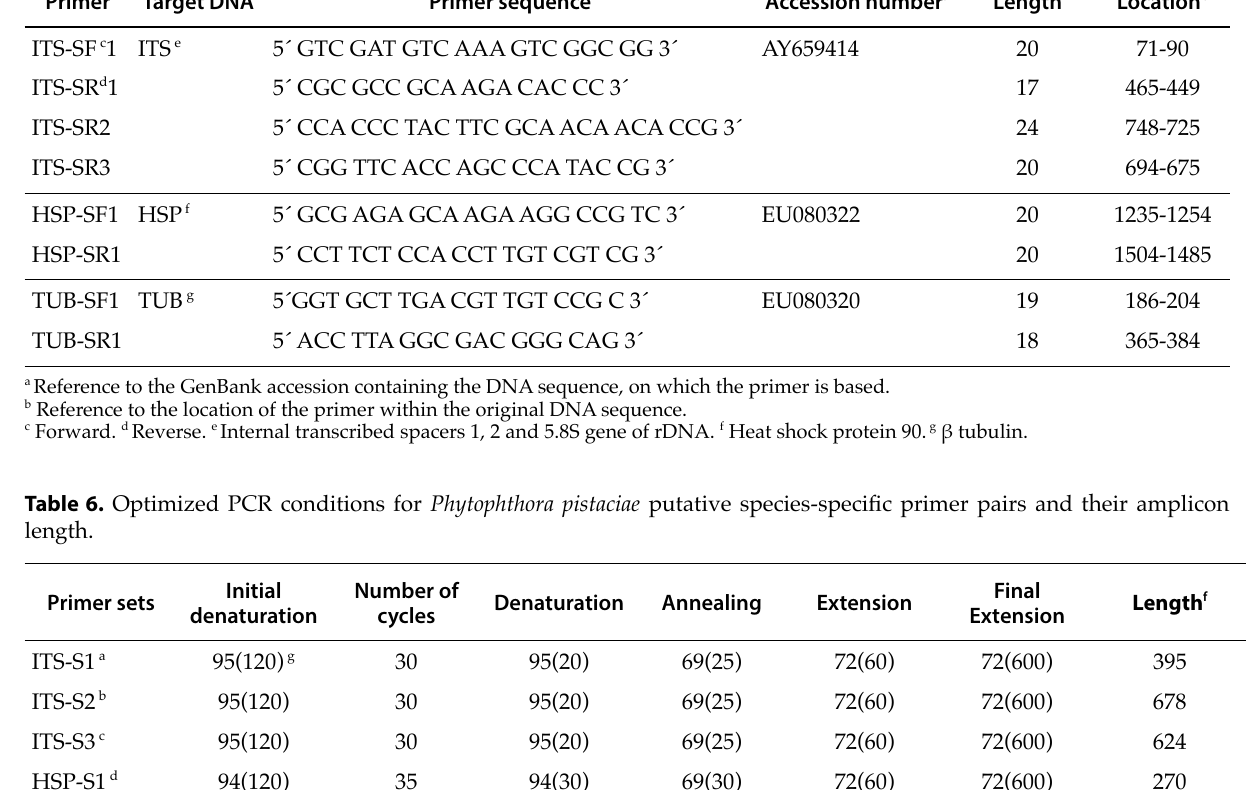
Table 5. The putative specific primers designed for detection of Phytophthora pistaciae . Primer